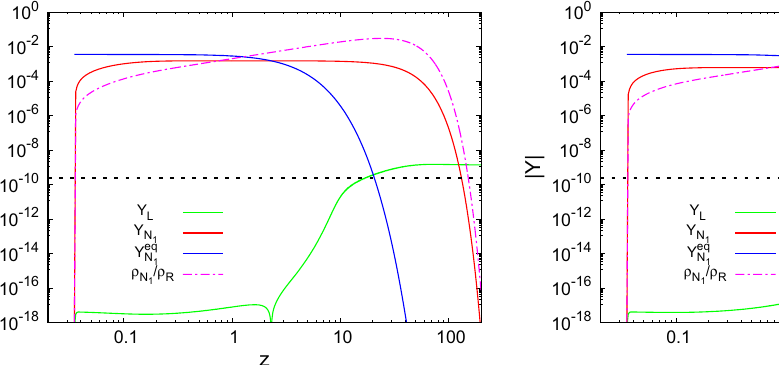
= Y = 0 at z = z ρ /ρ Y N L R . N 1 R represents a ratio of the energy 1 density of N 1 to the one of